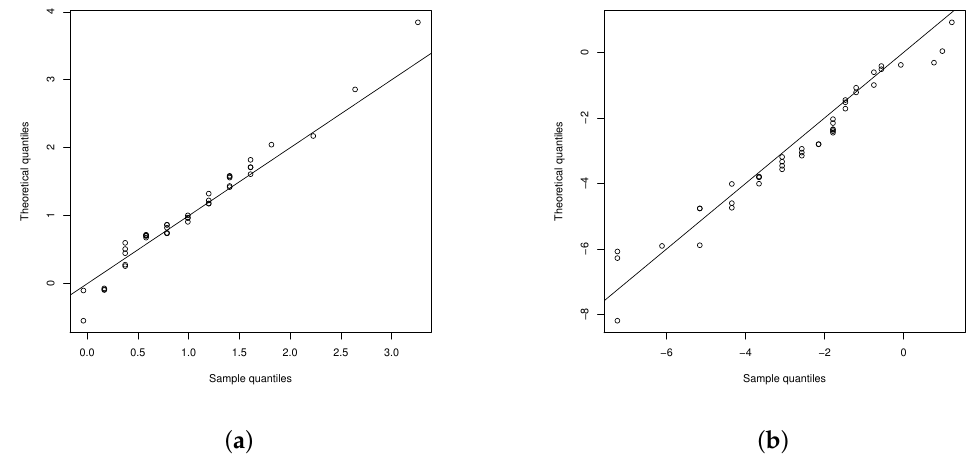
Figure 3. QQ-plots for SHPN models. ( a ) CO 2 and ( b ) O 3 .